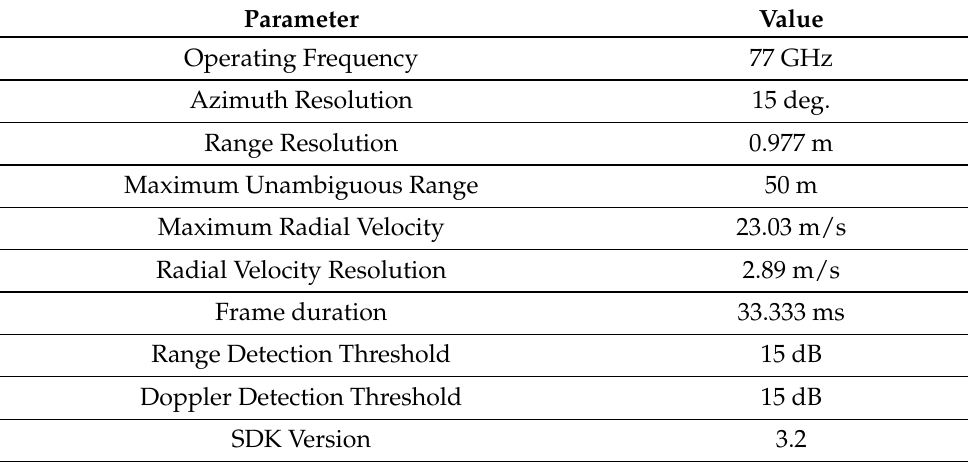
Figure 1. Experimental setup. In clockwise order: ( A ) Lateral view of the setup. ( B ) FOV from the camera. ( C ) Top down view of the setup. Table 1. Parameters used for the 1843 mmWave Radar